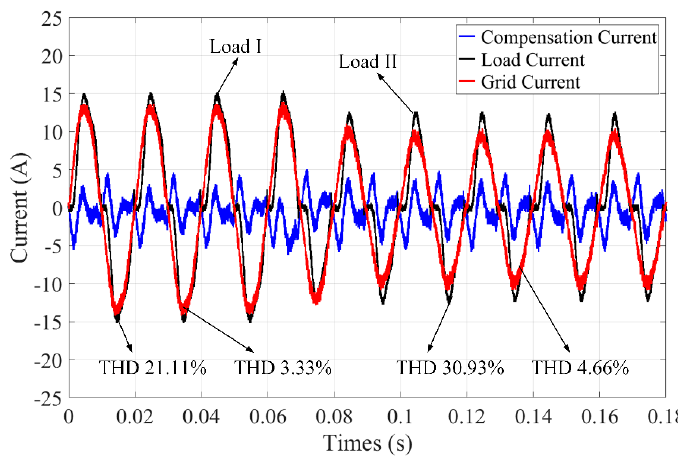
Figure 14. Experimental results of the current waveforms for the sawtooth PCFM APF with ∆ f c = 800 Hz under the load change condition.